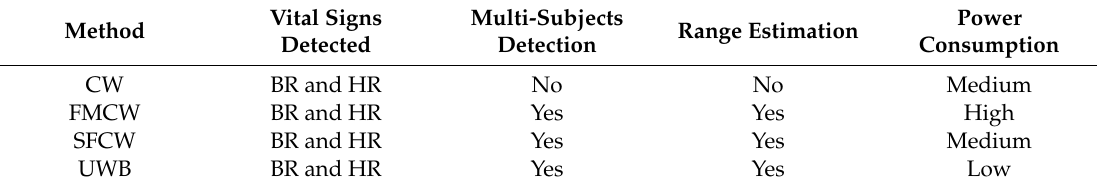
Table 2. Comparison of Radar-Based Vital Signs Monitoring